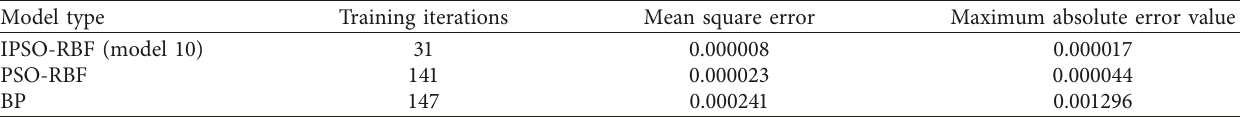
Figure 13: Comparison of BP-predicted and real values. Table 5: Complexity classification of the servo